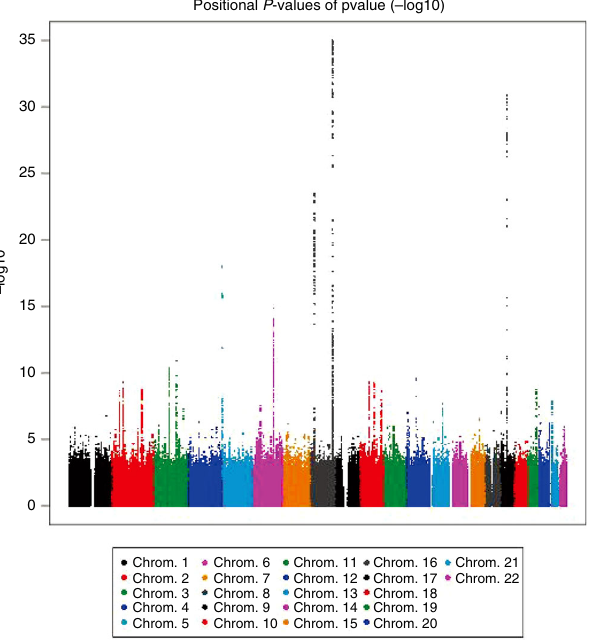
Fig. 2 Manhattan plot of GWAS. − log10 P value is plotted on the Y -axis. Each P value is calculated by a 1-degree-freedom Cochran-Armitage test